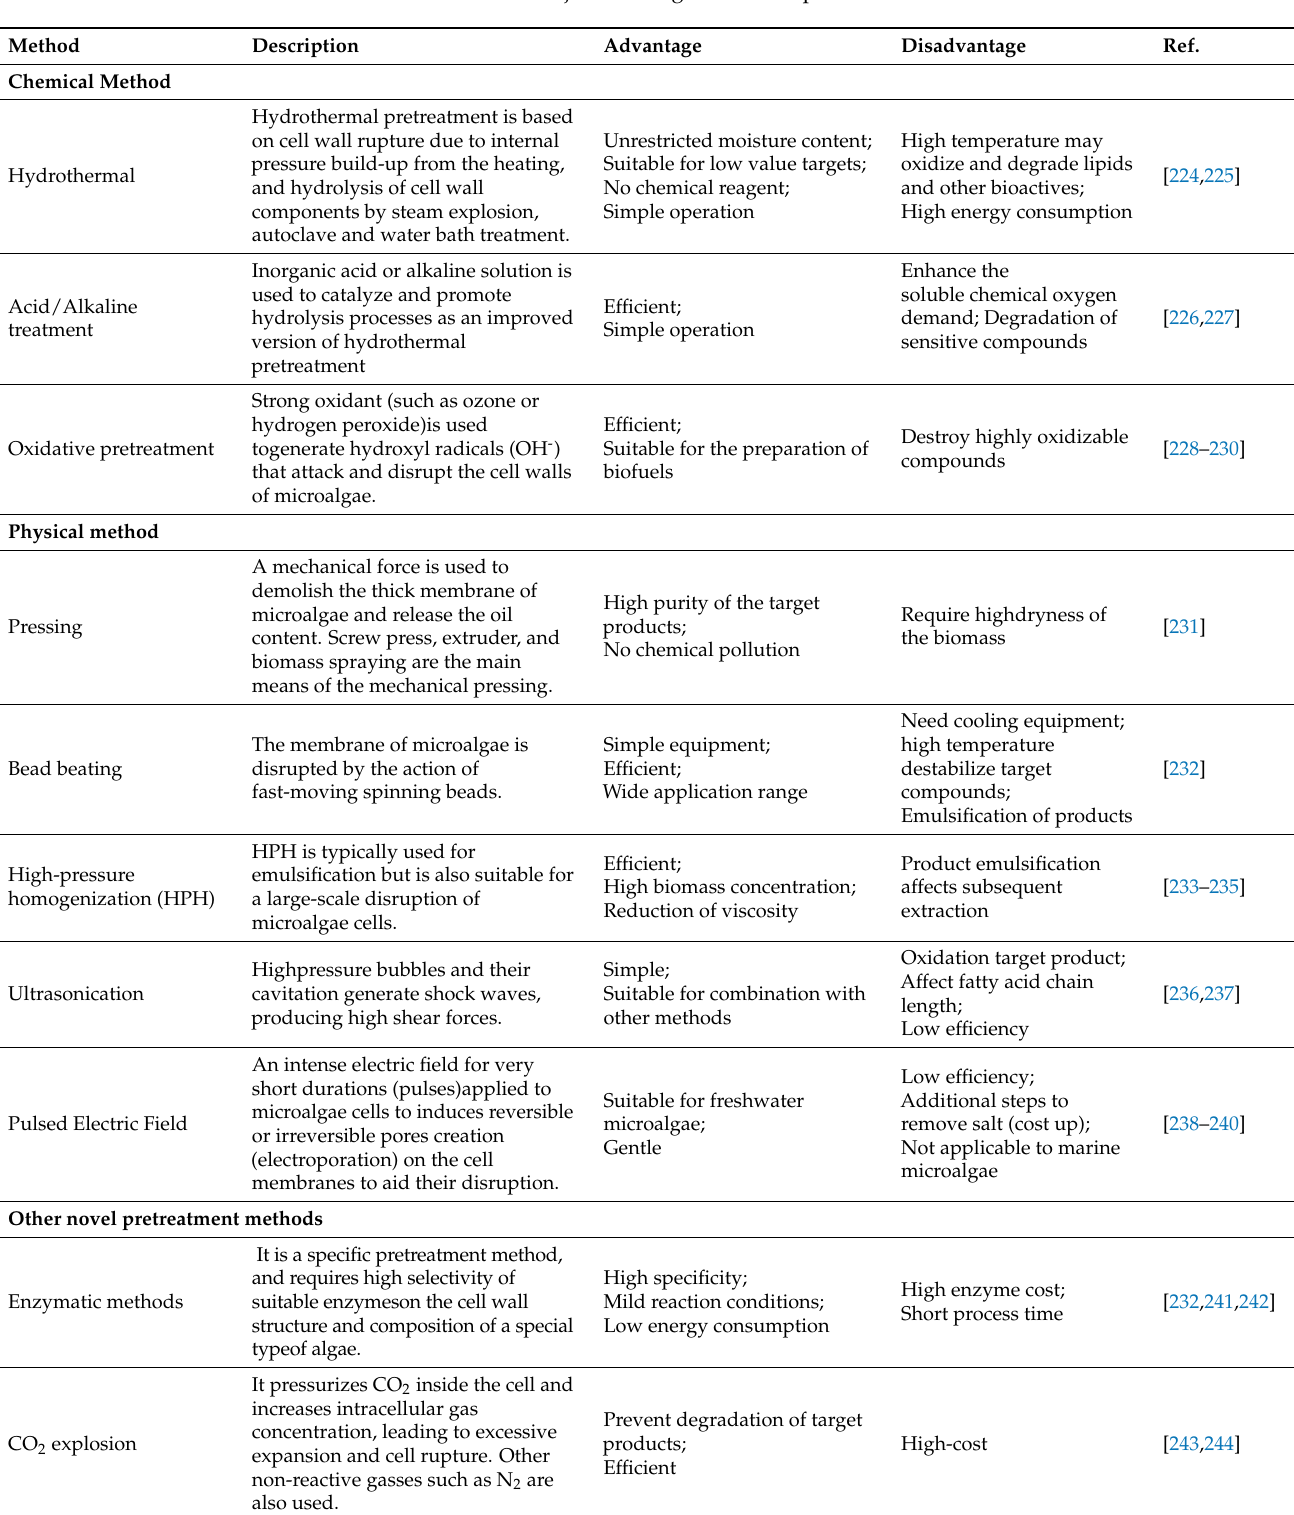
Table 3. Overview of major microalgae cell disruption